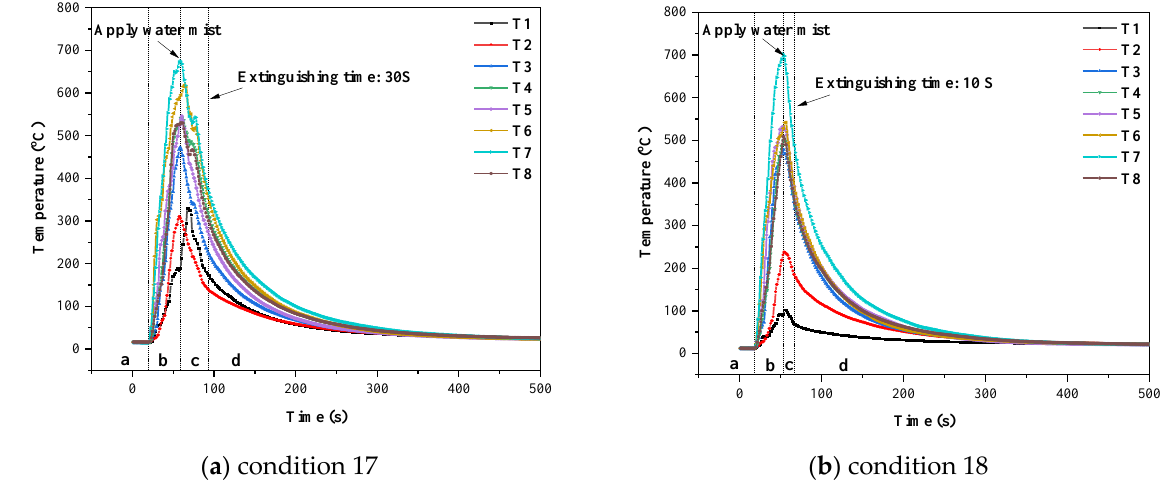
Figure 8. Temperature curve of flame thermocouple under test conditions 17 and 18.